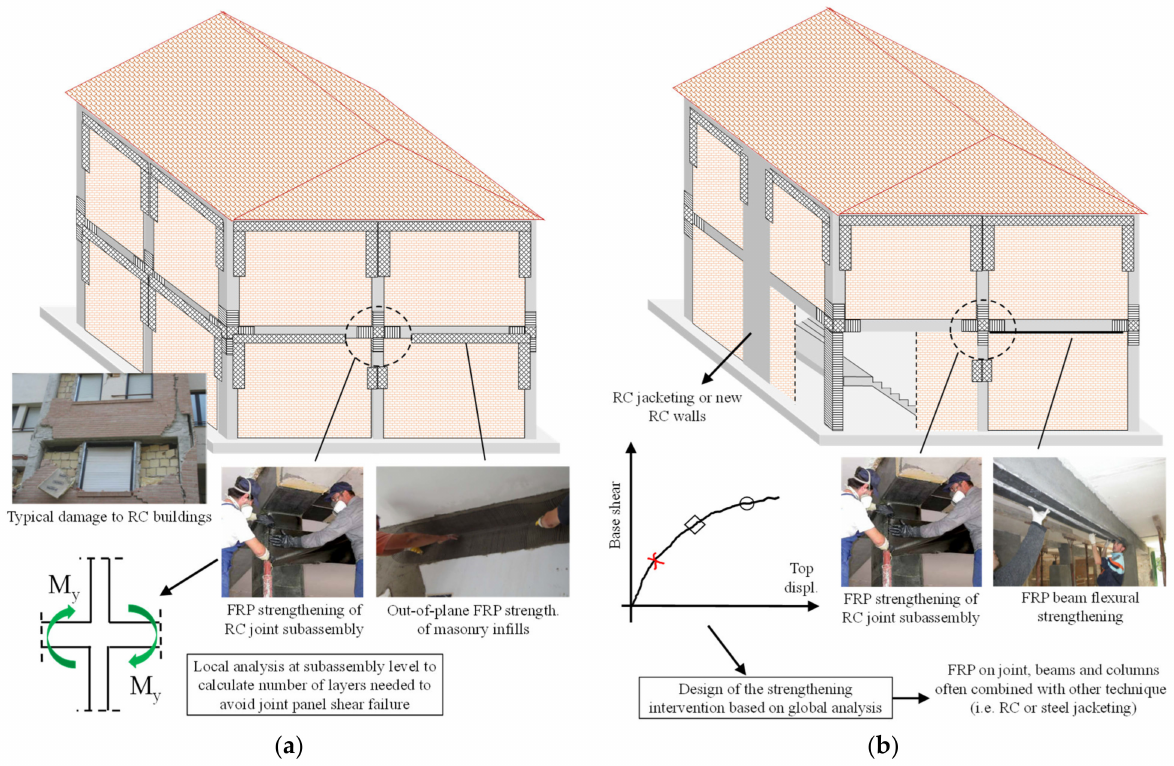
Figure 1. Strengthening strategies adopted during the L’Aquila reconstruction process: Local strengthening of exterior RC beam-column joints and infills to prevent out-of-plane failure ( a ); Global strengthening ( b